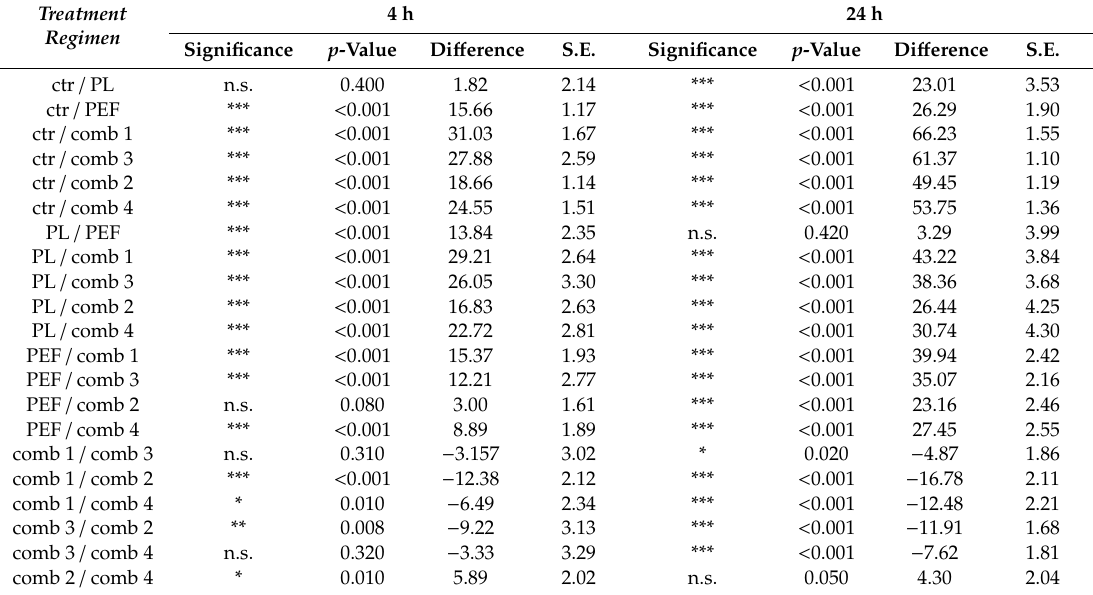
Table 2. Statistical analysis of cell viability 4 and 24 h after treatment. A multiple t-test was performed (* p < 0.05; ** p < 0.01; and *** p < 0.001). ctr = control; PL = plasma; PEF = pulsed electric fields; comb = combination; n.s. = not